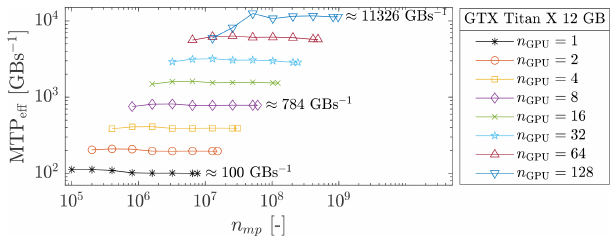
Figure 18. MTP eff sum across the GPUs